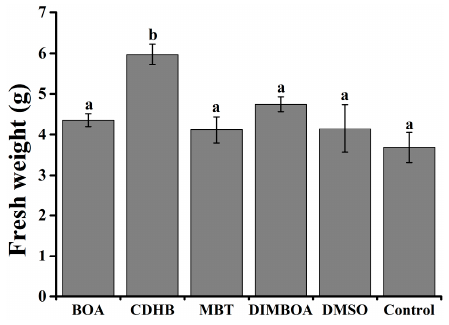
Figure 5. Effects of DIMBOA and its derivatives at the minimum inhibitory concentrations on tobacco fresh weight. The 10-mL solution of DIMBOA and its derivatives (MICs) and DMSO (0.3%) were respectively irrigated into the rhizosphere of each 4-week-old tobacco seedling, then the fresh weight was measured after 7 days. The assays were independently repeated three times. BOA at concentrations of 300 mg/L; CDHB at concentrations of 100 mg/L; MBT at concentrations of 50 mg/L; DIMBOA at concentrations of 200 mg/L. The error bars indicate the standard error of the mean from three replicates. Lower case letters indicate significant differences according to Duncan’s test ( p < 0.05).